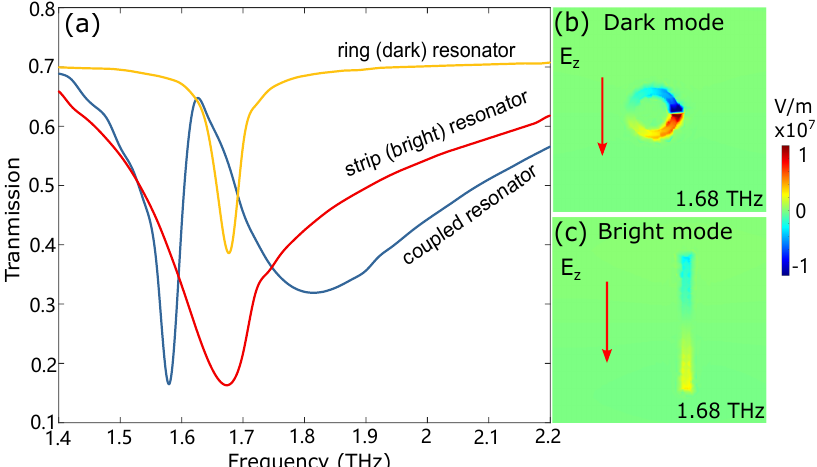
Figure 2. ( a ) Transmission spectra of the strip resonator (red), ring resonator (yellow), and coupled strip/ring resonator (blue) without graphene. The transmission dips of ring and strip resonator are both at 1.68 THz. The EIT induced transparency window due to bright–dark-mode coupling is at 1.62 THz. ( b , c ) The electric field E z distribution of the dark resonator and bright resonator at the transmission dips when they are excited by the incident field separately. The arrows represent the current directions in the